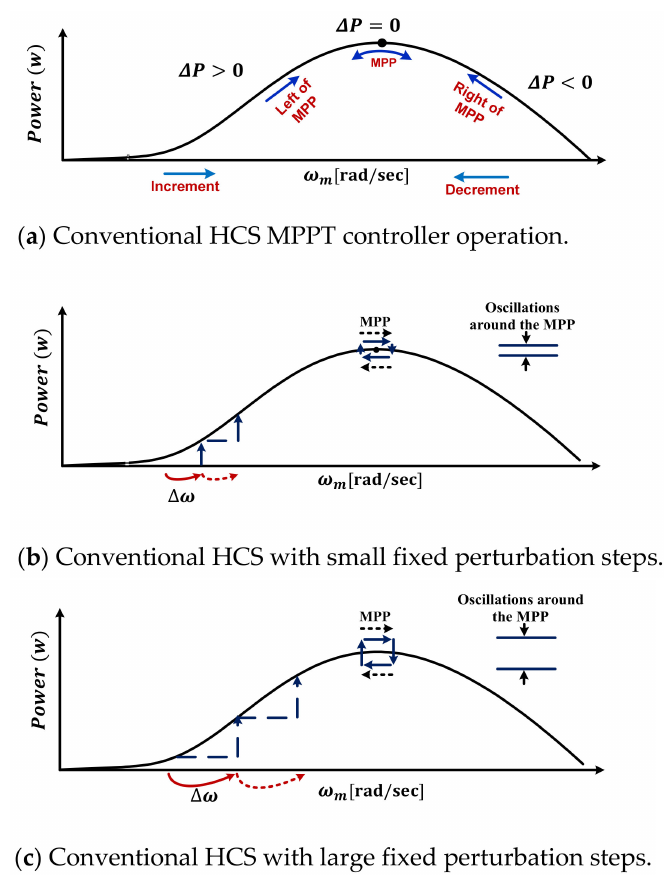
Figure 5. Conventional HCS MPPT